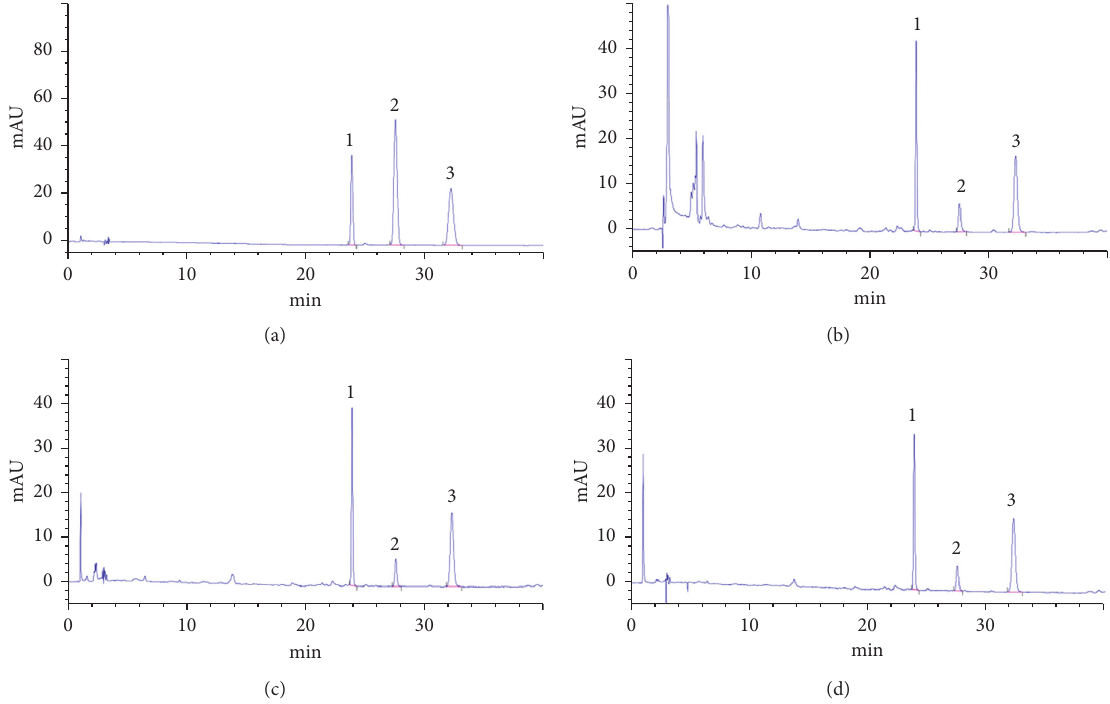
Figure 3: HPLC chromatograms of mixed standard solutions (a); DES test solutions (b); methanol test solutions (c); ethanol test solutions (d) (1: POG, 2: CIM, 3: